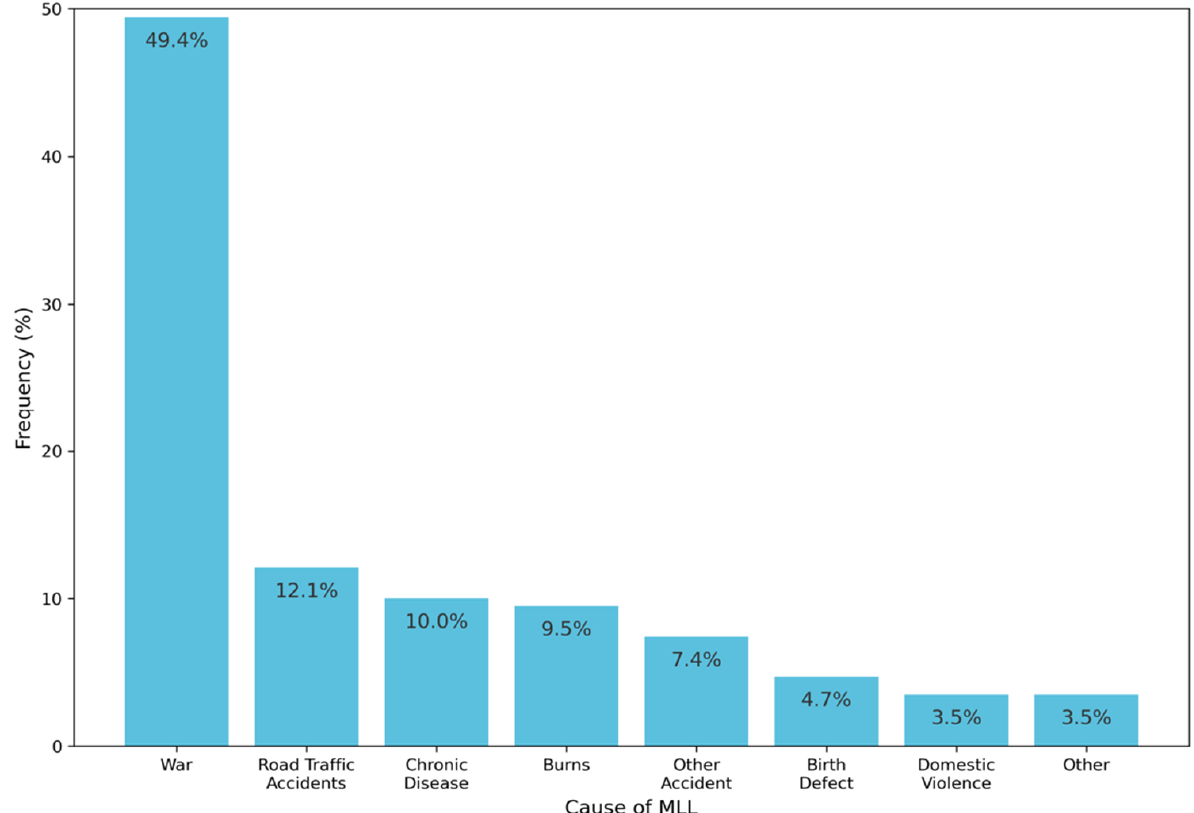
Figure 2. The frequencies of the causes of MLL in the Acholi sub-region.